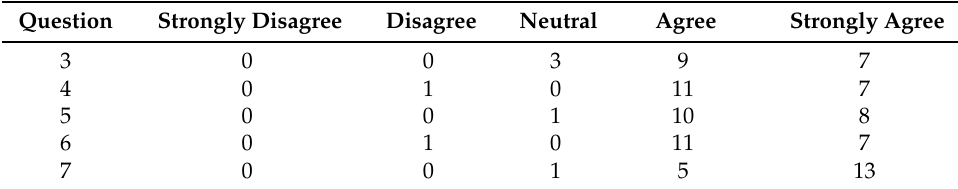
Table 8. Student questionnaire responses, Liker-type questions.